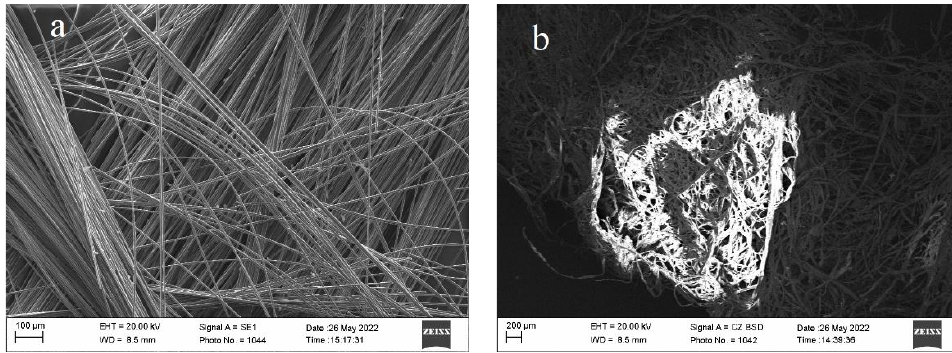
Figure 2. Scanning electron microscope image of CF ( a ) and MCF ( b ).